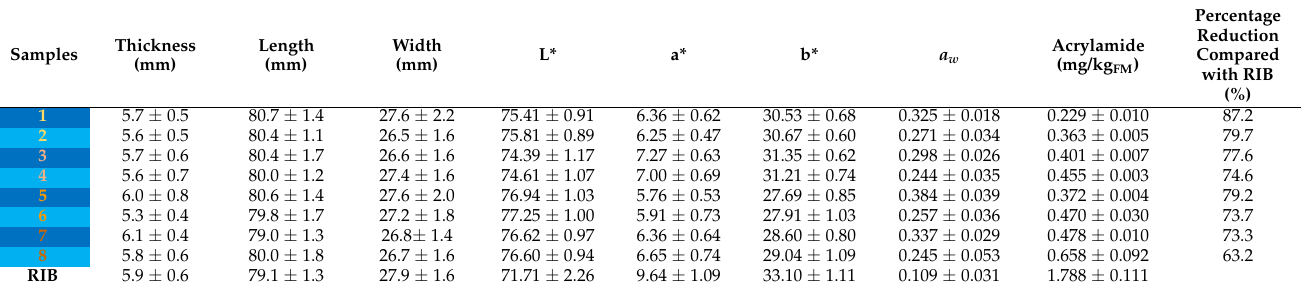
Table 3. Results of measurements of size, CIELab color parameters, water activity, and acrylamide (expressed as mg/kg FM ; FM : fresh matter) carried out on FDOE samples (samples 1–8) and reference samples